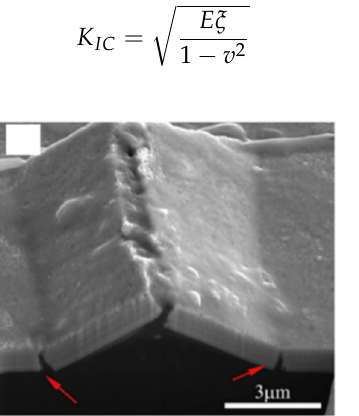
Figure 8. Respective SEM images showing the buckles in Cu/Nb NMMFs after uniaxial tensile testing [52].